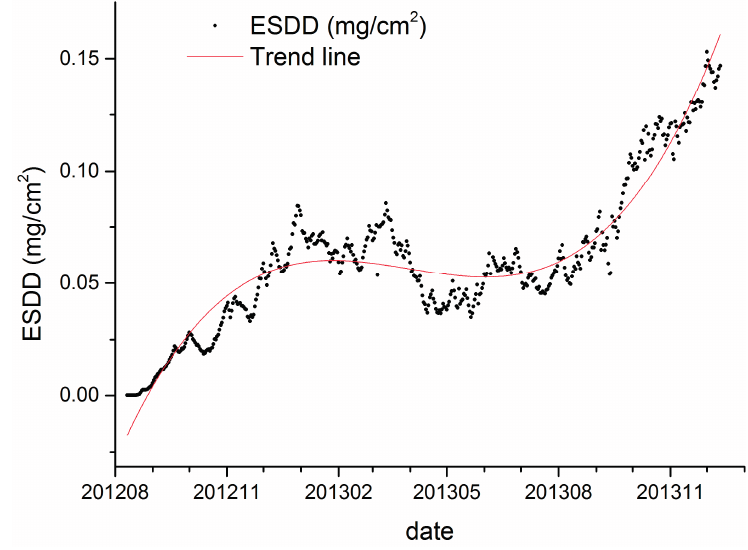
Figure 11. Mean daily ESDD and its trend line in